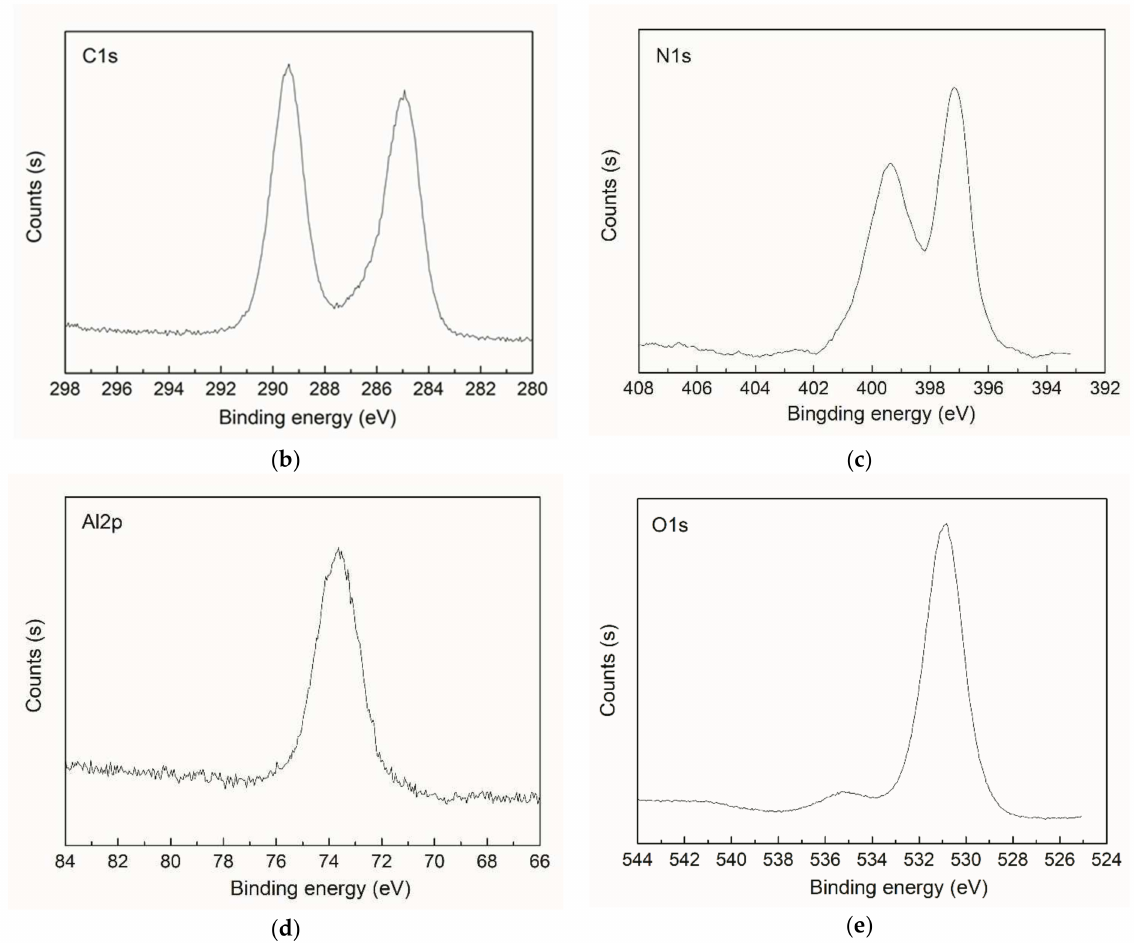
Figure 3. Wide-scan XPS spectrum of 15CPCMs ( a ). High-resolution scan for ( b ) C1s, ( c ) N1s, ( d ) Al2p and ( e ) O1s core